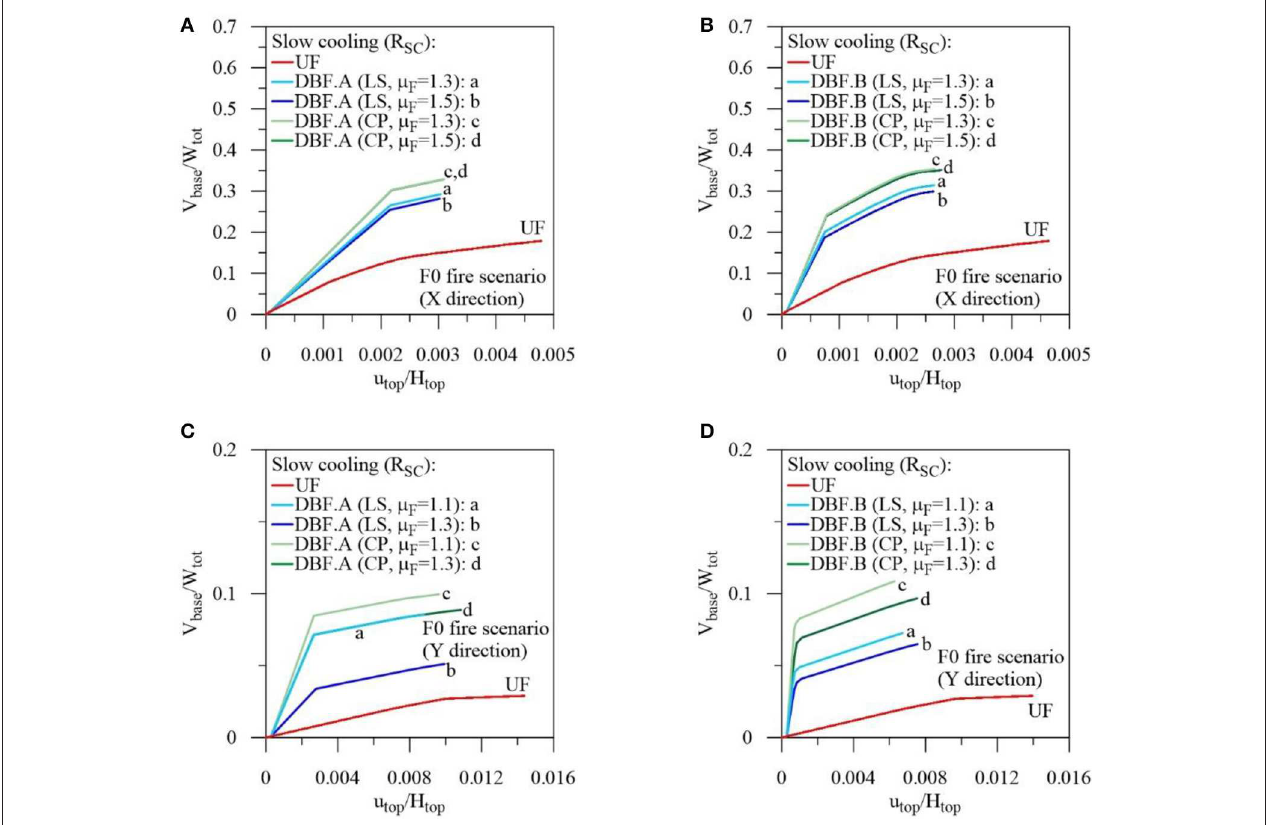
FIGURE 11 | Comparison of pushovers curves along the in-plan X and Y directions for the retrofitted Collina-Castello school, at LS and CP limit states. (A) Constant drift ratio criterion: X direction. (B) Proportional stiffness criterion: X direction. (C) Constant drift ratio criterion: Y direction. (D) Proportional stiffness criterion: Y